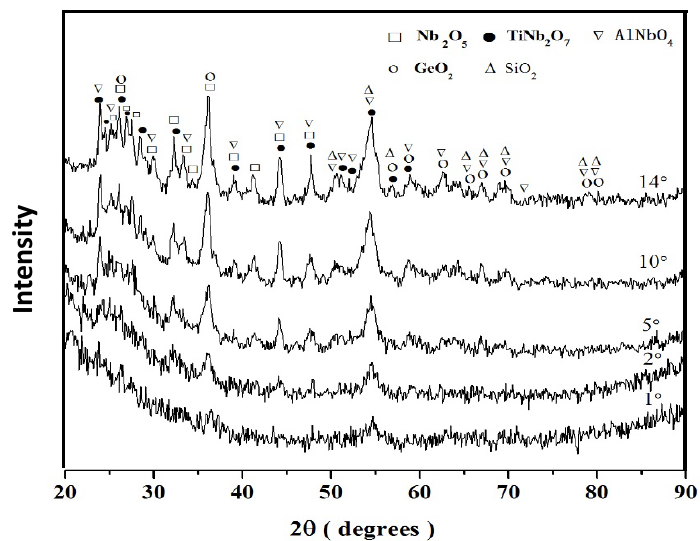
Figure 5. GXRD data (γ = 1°, 2°, 5°, 10°, and 14°) for the scale formed on the alloy ZF5 after oxidation in air at 800 °C.